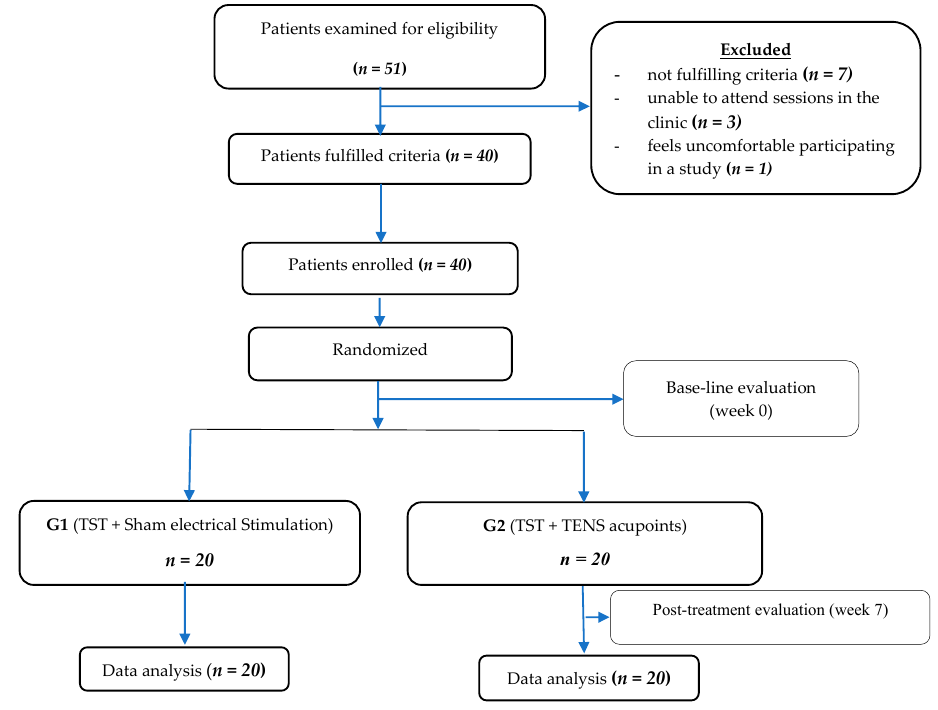
Figure 1. Diagram showing the flow of the study. Table 1. Demographic and baseline clinical characteristics in both groups, pretreatment.